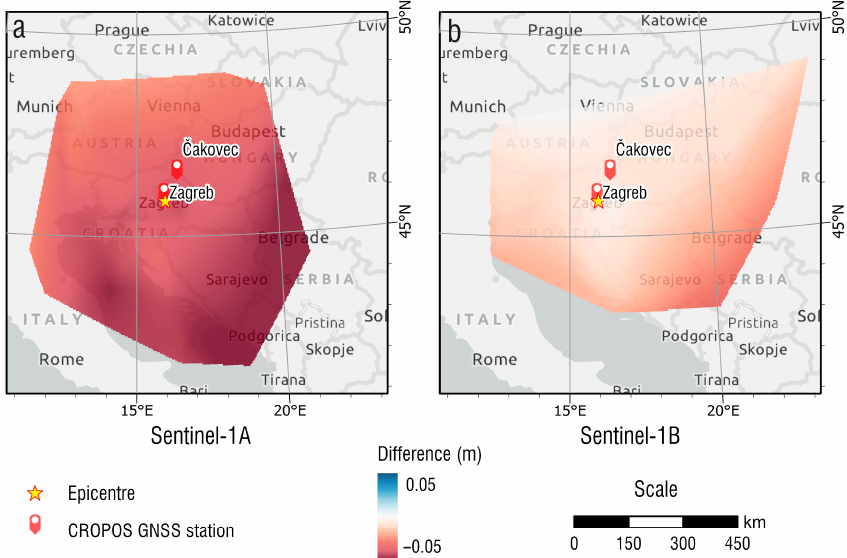
Figure 7. Difference between vertical single ionospheric crossing errors for Sentinel-1A ( a ) and Sentinel-1B ( b ) DInSAR pairs.